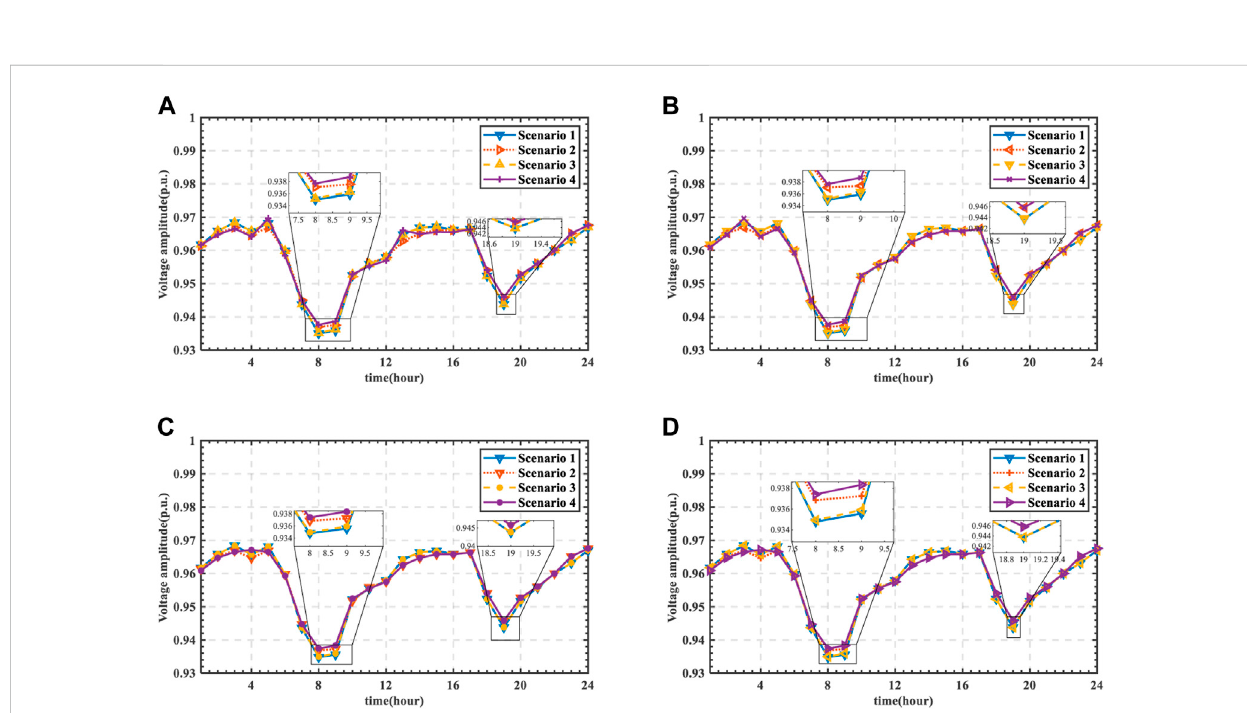
FIGURE 11 Distribution of minimum voltage amplitude for the shortest